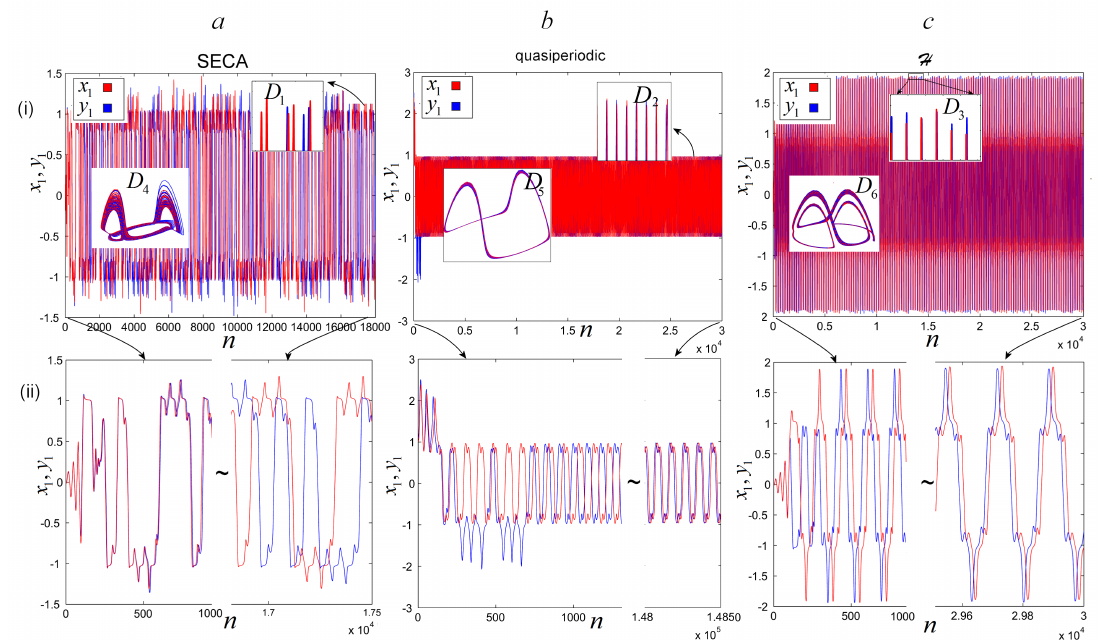
Figure 7. Difference between the first components x 1 and y 1 of two close trajectories x and y . ( a ) The SECA for b = 0.98; ( b ) the quasiperiodic attractor corresponding to b = 0.25675; ( c ) the HSNA H ; (i) overplot of x 1 and y 1 with zoomed details and three-dimensional representations; (ii) details of (i).